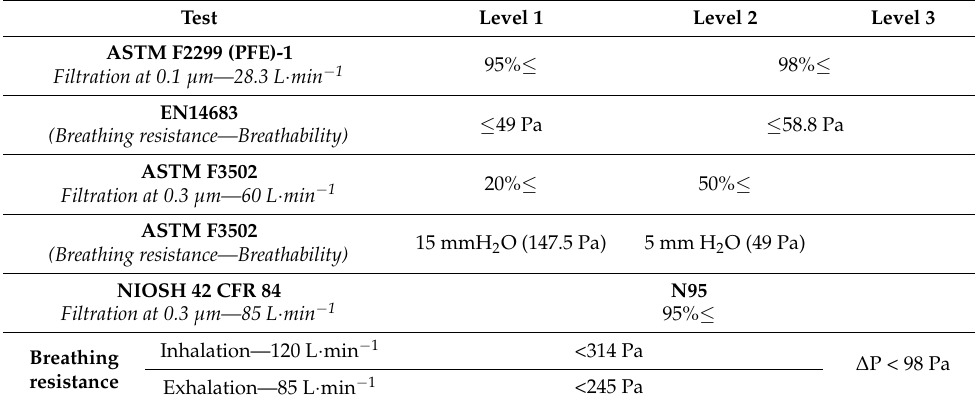
Table 1. Comparison of filtration test method